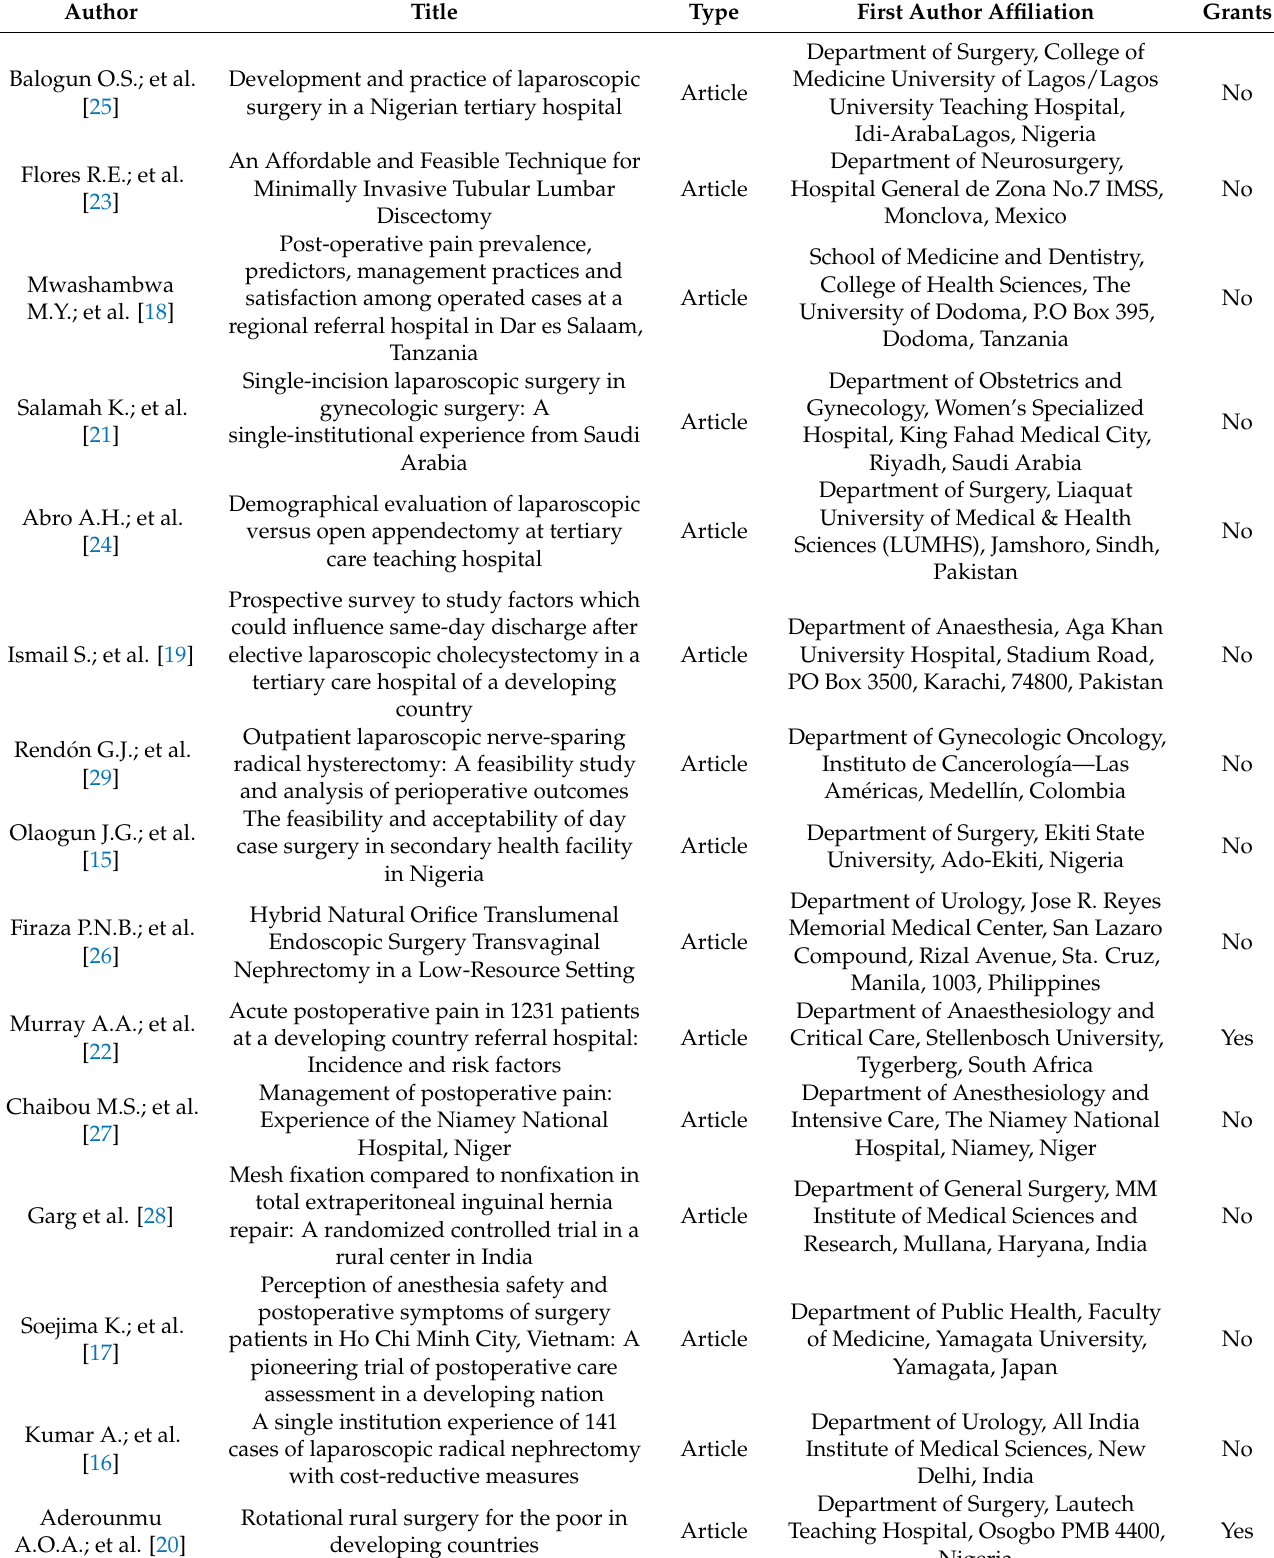
Table 1. Characterization of the studies included in the